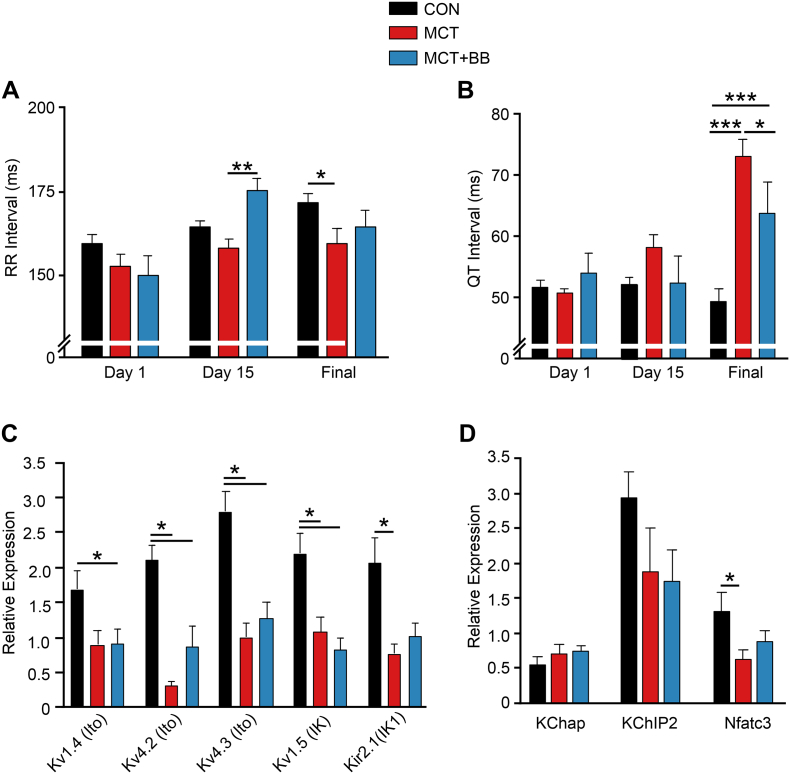
BB attenuated electrical remodeling. Telemetric recording of ECGs during the light (inactive) period on day 1, day 15 (prior to vehicle or BB treatment) and final experimental day. A On the final day there was a decrease in RR interval in MCT animals compared to CON, this effect was attenuated by BB treatment. B BB treatment significantly reduced the QT prolongation seen in MCT. C Final day mRNA levels for channels carrying repolarising K+ currents were significantly reduced in MCT compared with CON. For the main channel carrying IK1 there was intermediate expression in MCT + BB animals for Kir2.1. D Final day mRNA levels for K+ channel subunits KChap and KChIP2 did not vary between groups but the expression of the Kv regulator Nfatc3 was reduced in MCT compared with CON, while MCT + BB hearts showed intermediate levels. A, BN = 9–12 animal in each group, two-way ANOVA. C, DN = 10 animals in each group, one-way ANOVA. *P < .05, **P < .01, ***P < .001.